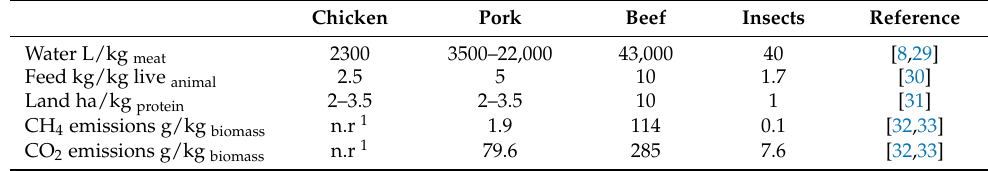
Table 1. Environmental impact of mealworms and cricket compared to other animal